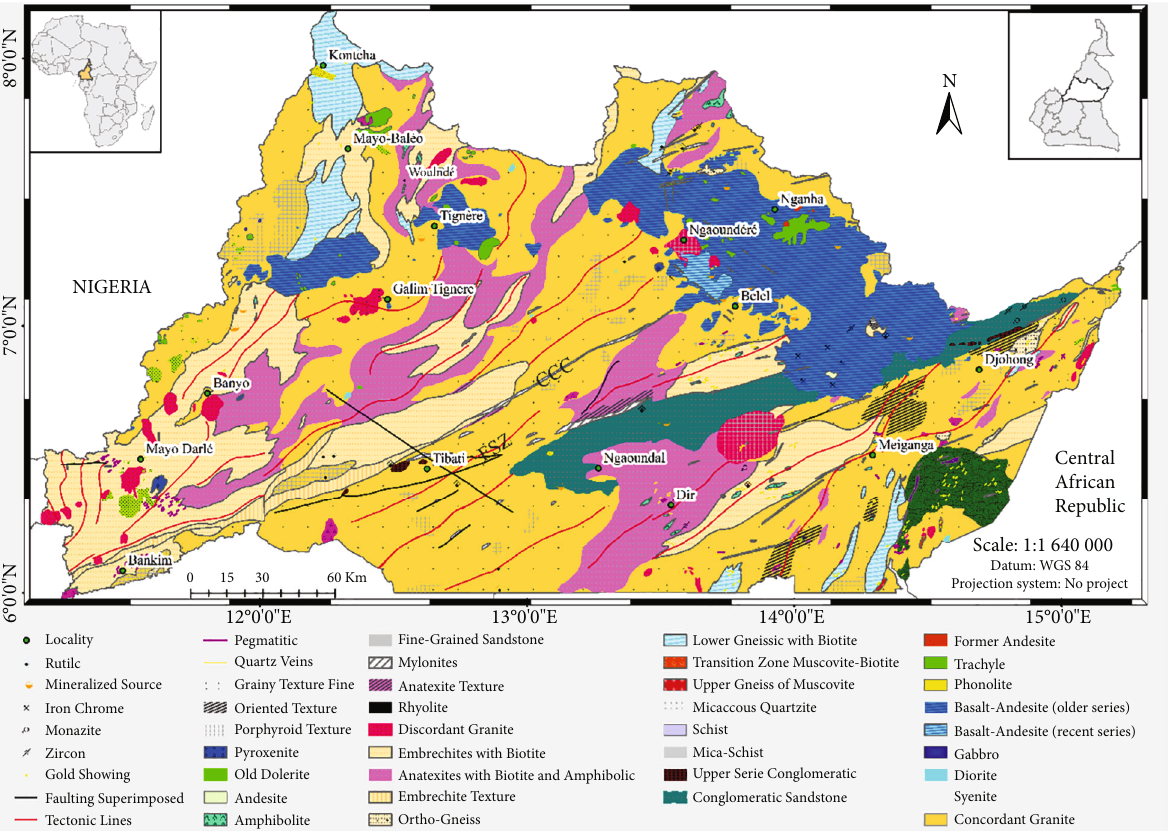
Figure 1: Geological map of Adamawa area (modi fi ed from [4, 22,